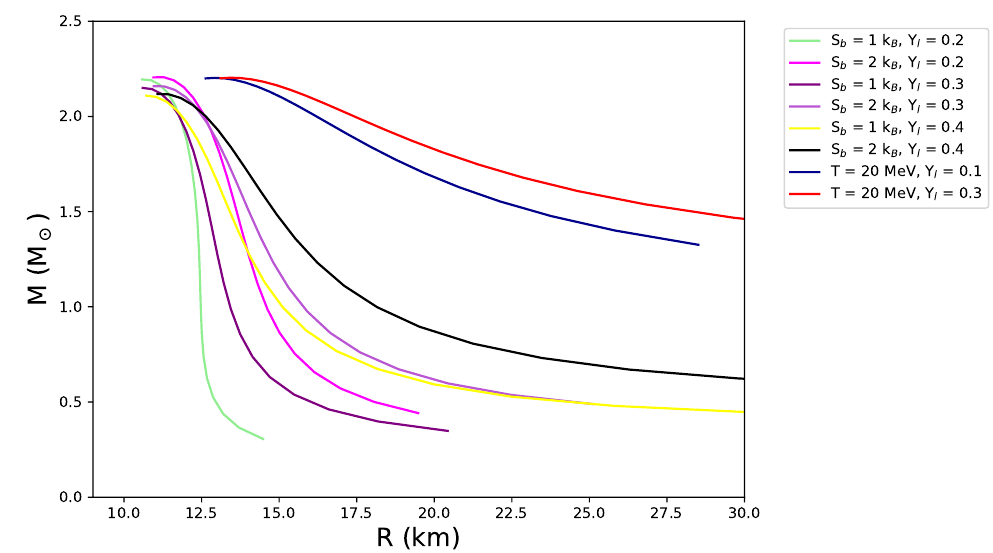
Figure 2. Mass–radius dependence for the MDI-APR1 EOS at finite